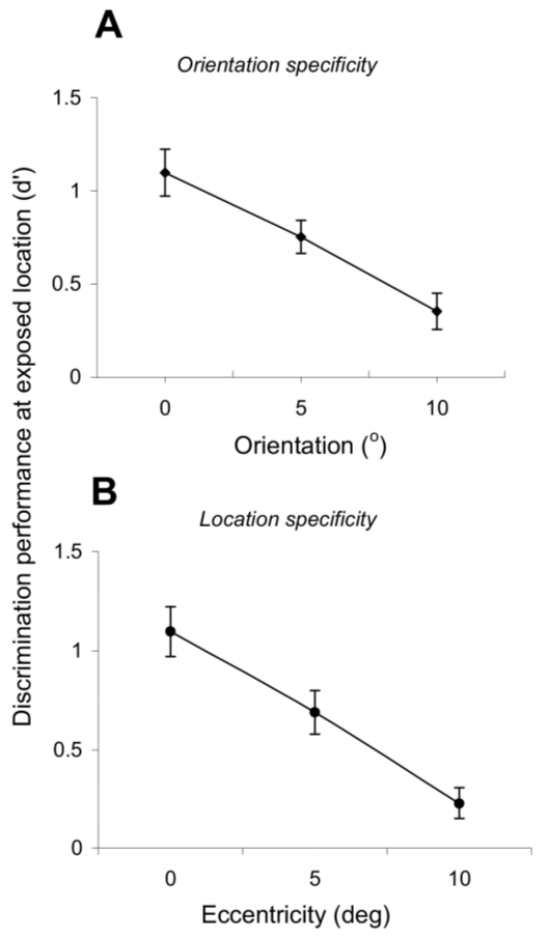
Figure 4. Specificity for orientation and retinal position. ( A ) Orientation specificity. The orientation discrimination performance at the exposed location gradually decreases as the test differs from the experienced orientations. Each point represents the mean performance (measured using d’) obtained by averaging data across four test sessions when the target orientation was 5° and 10° away from the exposed orientations (exposure to 60°–150° followed by tests at 65° and 70°). ( B ) Position specificity. The orientation discrimination performance at the exposed location gradually decreases as the eccentricity at which the orientation discrimination test was performed increases. Each point represents the mean performance (measured using d’) obtained by averaging data across four test sessions when the test location was 5 and 10 ° away from the exposed location (exposure to 0 ° eccentricity followed by tests at 5 and 10 ° eccentricity on the horizontal axis). Error bars represent SEM.